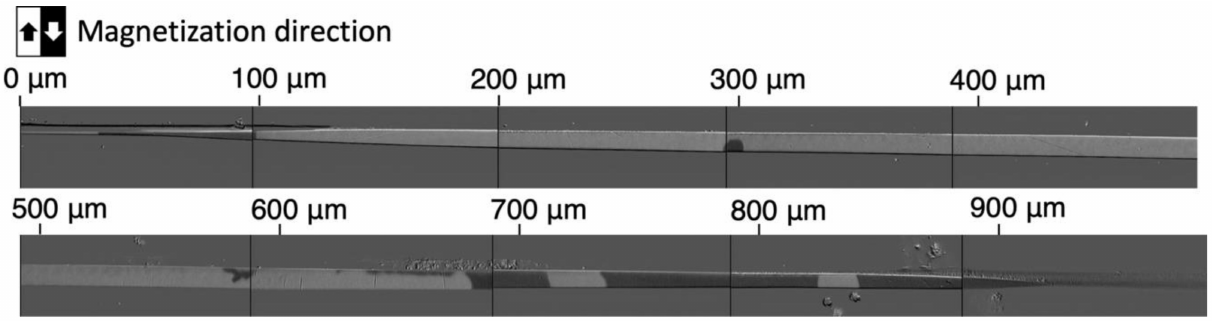
Figure 2. Overall view of the polished surface of an amorphous magnetic